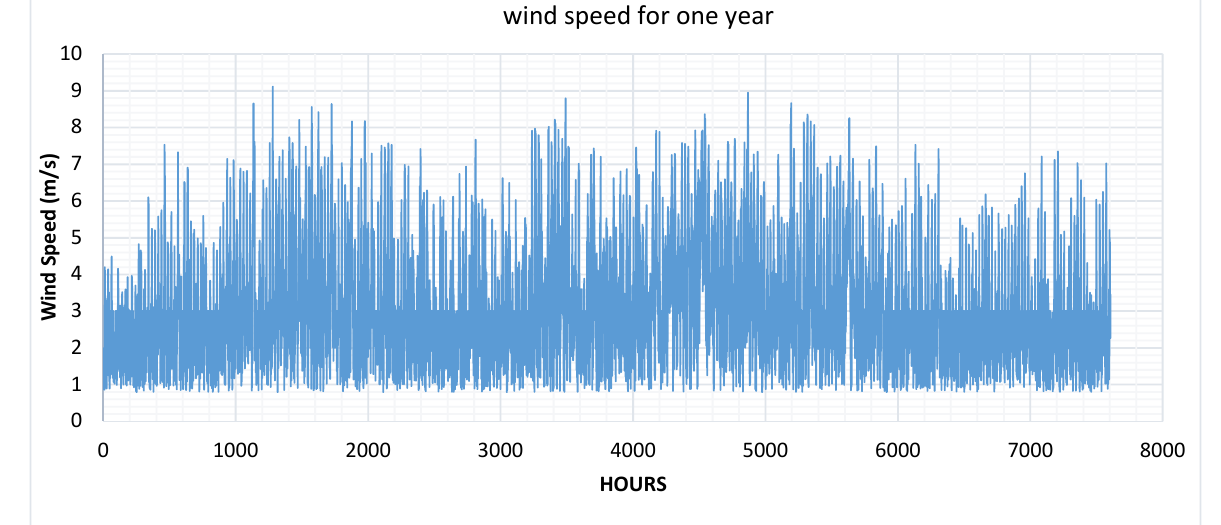
Figure 2. Wind speed of the site location.